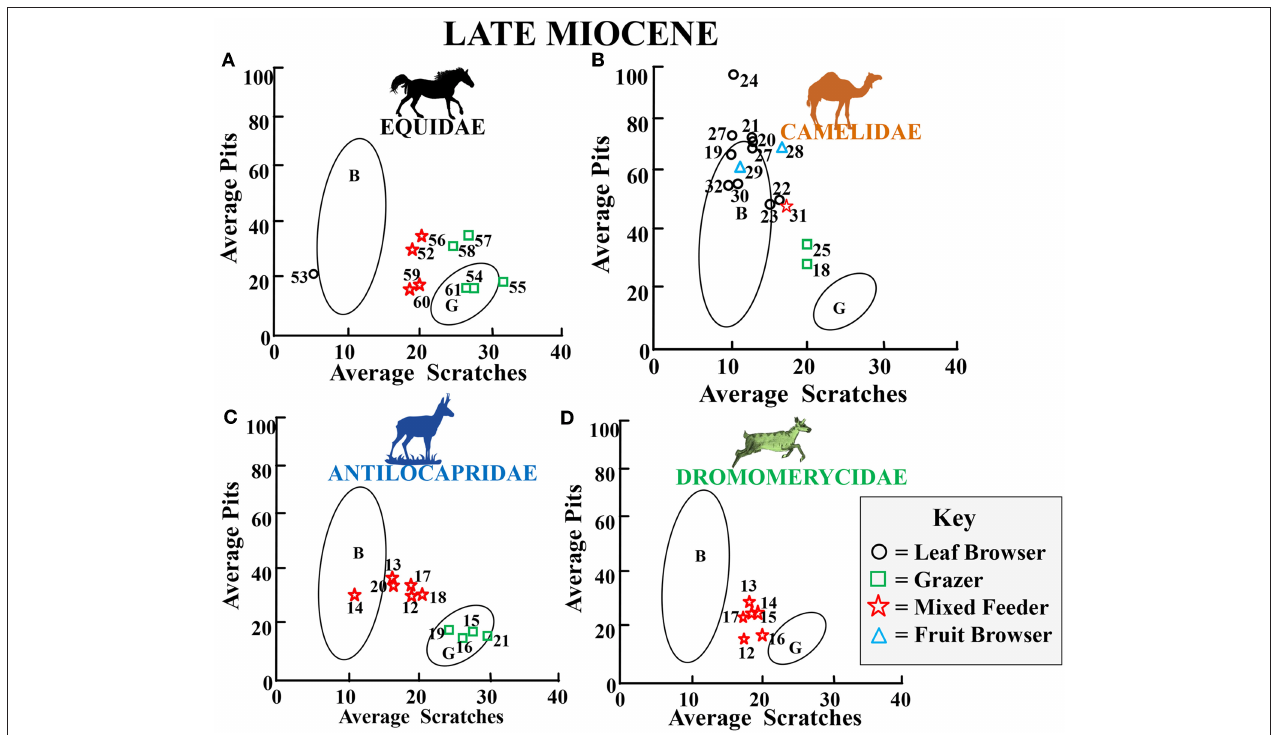
FIGURE 12 | Bivariate plot showing results for the average number of pits vs. the average number of scratches per taxon for Late Miocene fossil equids (A) , camelids (B) , antilocaprids (C) , and dromomerycids (D) plotted in reference to extant leaf dominated ungulate browsers (B), and extant grazers (G) at 35 times magnification (extant comparative data from Semprebon, 2002 and Solounias and Semprebon, 2002). Gaussian confidence ellipses ( p = 0.95) on the centroid are indicated for the extant leaf browsers (B) and grazers (G) (convex hulls) adjusted by sample size. Key to Equidae: 52 = Pseudhipparion hessei , 53 = Hypohippus sp., 54 = Calippus martini , 55 = Cormohipparion occidentale , 56 = Hipparion tehonense , 57, 60 = Dinohippus leidyanus , 58, 61 = Dinohippus sp. 59 = Dinohippus interpolatus . Key to Camelidae: 18, 19, 21, 22 Megatylopus sp., 20, 27, 29 = Procamelus sp., 23 = Machaerocamelus sp., 24 = Procamelus occidentalis , 25, 30, 31, 32 = Hemiauchenia sp., 28 = Megacamelus sp. Key to Antilocapridae: 14 = Plioceros dehlini , 13 = Proantilocapra platycornea , 12 = Cosoryx cerroensis , 15 = ? Hexobelomeryx sp., 16, 21 = Ilingoceros alexandrae , 17 = Osbornoceros osborni , 18 = Texoceras guymonensis 19 = ” Plioceros ” texanus , 20 = cf. Sphenophalos . Key to Dromomeryidae: 12 = Cranioceras clarendonesis , 13 = Cranioceras unicornis , 14 = Pediomeryx hamiltoni , 15 = Pediomeryx hemphilliensis (Guymon Area), 16 = Pediomeryx hemphilliensis (Coffee Ranch), 17 = Pediomeryx